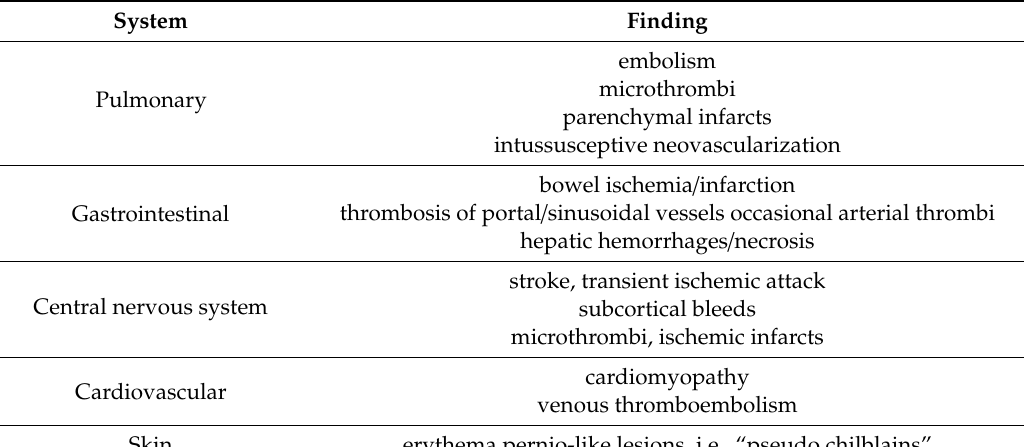
Table 1. Clinical and pathological vascular manifestations in SARS-CoV-2